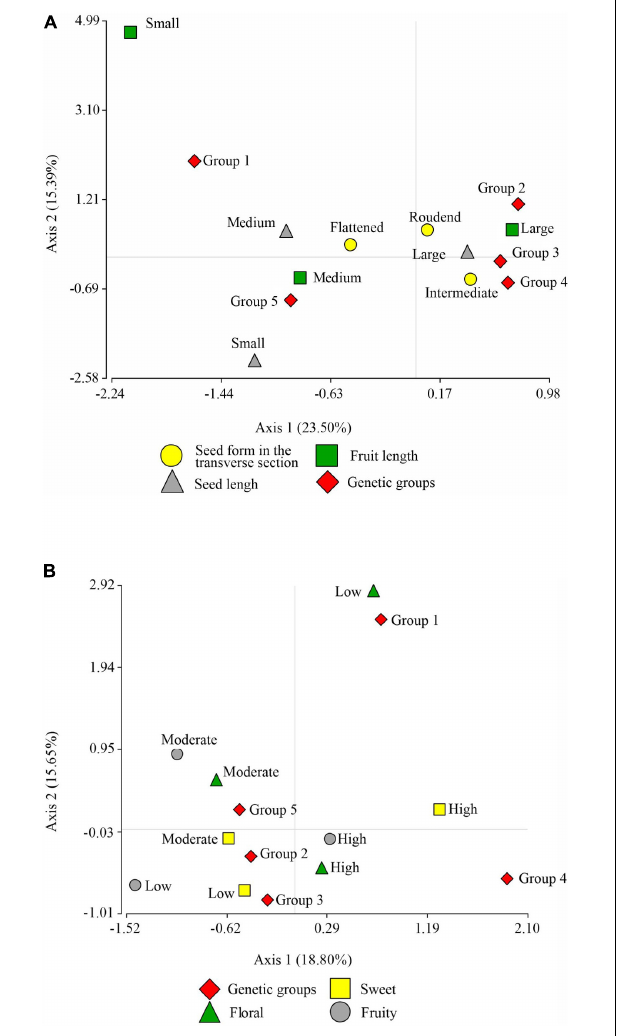
FIGURE 3 | Graph resulting from multiple correspondence analysis. (A) Between pod morphological descriptor variables: pod shape, pod wall thickness, pod basal constriction, and the association with the genetic groups. (B) Between pod morphological descriptor variables: pod rugosity, color of unripe pod fruits, ridge pair disposition, furrow depth, and the association with the genetic groups.